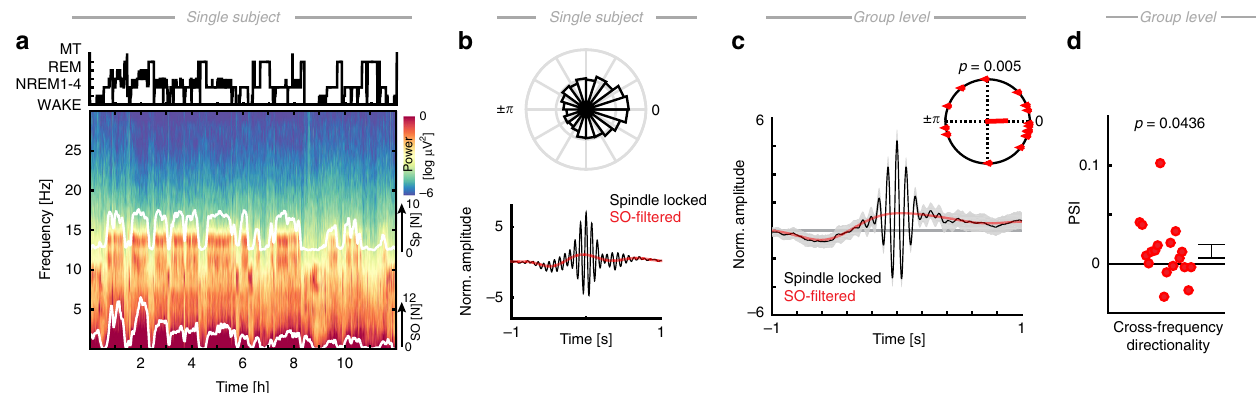
Fig. 1 Sleep architecture and coupled NREM oscillations. a Top: hypnogram of a single subject (MT = movement time). Bottom: corresponding multi-taper spectrogram with superimposed number of detected SO and sleep spindle events (white solid lines; 5 min averages). b Top: normalized circular histogram of detected spindle events relative to the SO phase. Note the peak around 0° (circular mean = 15.27°, i.e. after the SO peak). Bottom: peak-locked sleep spindle average across all detected events in NREM sleep (black). Low-pass fi ltered events (red) highlight that the sleep spindles preferentially peaked during the SO ‘ up-state ’ . c Peak-locked spindle grand average (black; N = 18; scalp EEG) superimposed with the SO low-pass fi ltered signal (red). Inset: spindles were signi fi cantly nested in the SO peak (V-test: p = 0.0050; red dots depict individual subjects). d Directional SO-spindle coupling as measured by the phase-slope index (PSI; mean ± SEM). SO phases signi fi cantly predicted spindle amplitudes (one-tailed t -test: p = 0.0436). Red dots depict